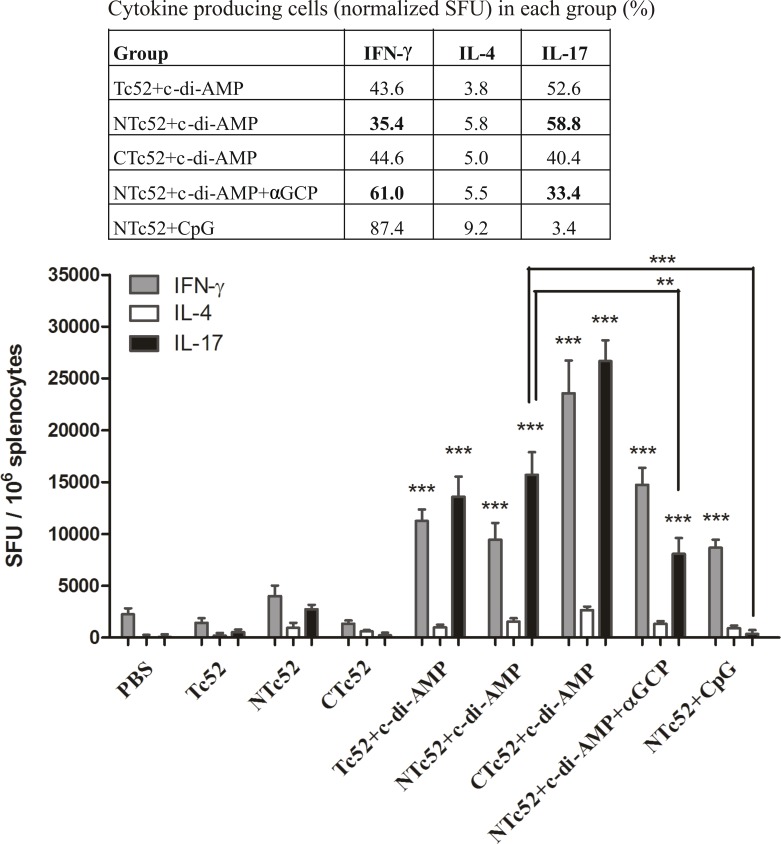
Cytokine profile developed after immunizations in vaccinated mice.Spleen cells were taken from each mouse 20 days after the last immunization. After stimulation with Tc52, IFN-γ, IL-4 and IL-17 producing cells were measured by ELISPOT. Results are expressed as spot forming units (SFU) normalized to 106 spleen cells, showing the mean and standard deviation of each group. In the table, the mean of normalized SFU of each cytokine is expressed as percentage of the sum of the three cytokines measures in the group to estimate the relative secretion of each cytokine, no the cells producing them. The change in cytokine profile in immunizations with c-di-AMP, with or without αCGP, is highlighted in bold. Results are representative of two independent experiments. **P < 0.01; ***P < 0.001.